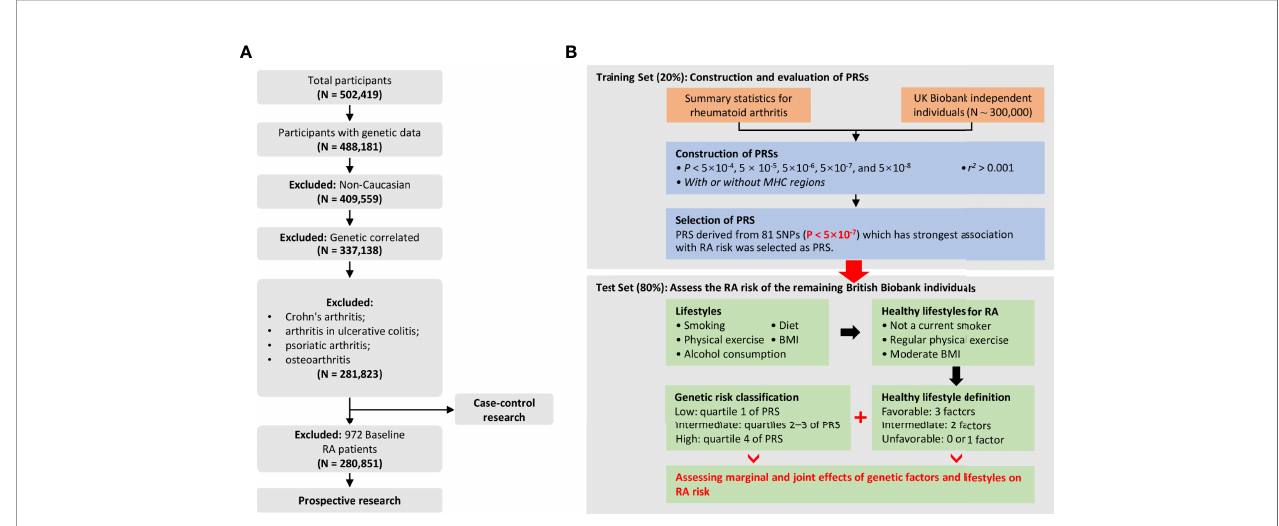
FIGURE 1 | (A) Flowchart for fi ltering participants from the UK Biobank cohort; (B) Study design and work fl ow of our